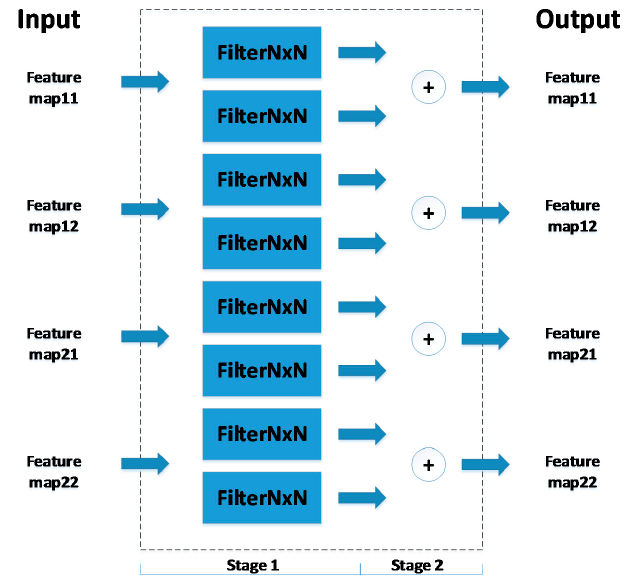
Figure 7. Architecture of the matrix convolution based on the Winograd algorithm.